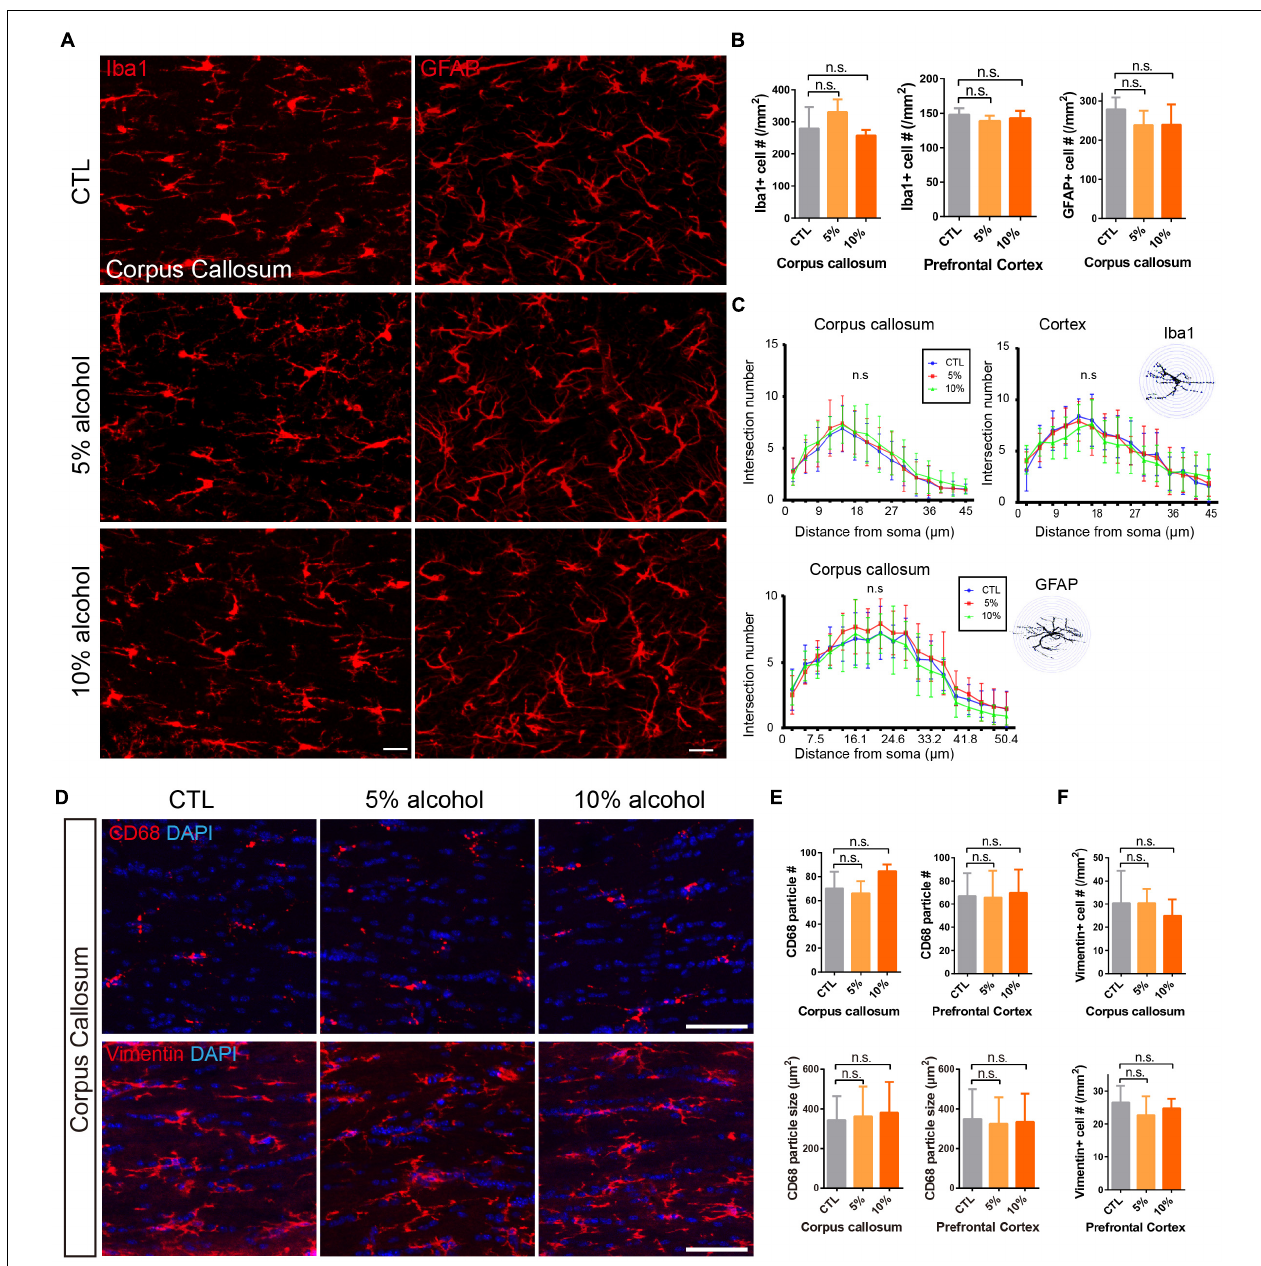
FIGURE 6 | Alcohol exposure does not activate astroglia or microglia. (A) Immunostaining of GFAP and Iba1 showing astrocytes and microglial cells in the corpus callosum. Scale bar 20 µ m. (B) Quantification of Iba1 positive cells in the corpus callosum and prefrontal cortex (n.s. p = 0.43 and 0.33, n = 4) and GFAP positive cells in the corpus callosum. (n.s. p = 0.11, n = 3) (C) The Sholl analysis showed comparable morphology of microglia and astrocytes in the corpus callosum and cortex in CTL and alcohol treated groups. (D) Immunostaining of CD68 and Vimentin showing astrocytes and microglial cells in the corpus callosum. Scale bar 50 µ m. (E) Quantification of the number of CD68 positive cells and the size of CD68 particles in the corpus callosum and prefrontal cortex. [n.s. p (number) = 0.08 and 0.96, p (size) = 0.07 and 0.12, n = 4] (F) Quantification of the number of Vimentin positive cells (n.s. p = 0.65 and 0.55, n =